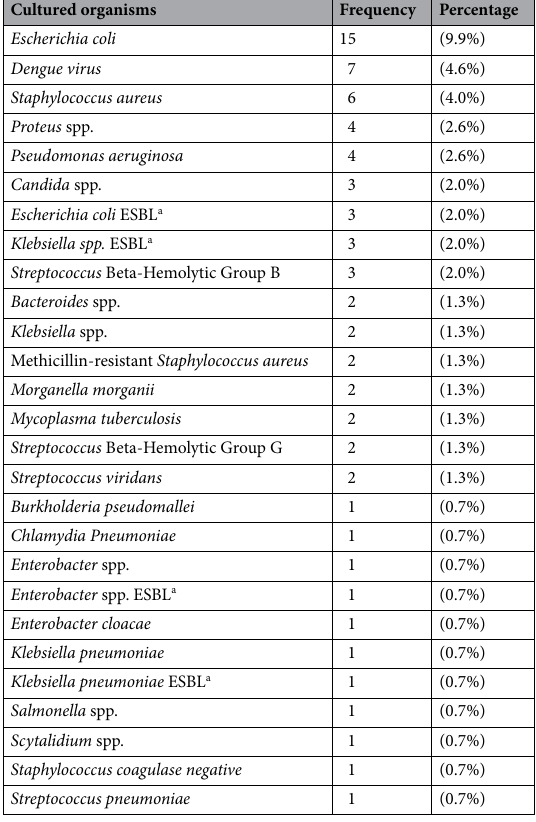
Table 2. Causative microbial detected via cultivation. a Extended-spectrum